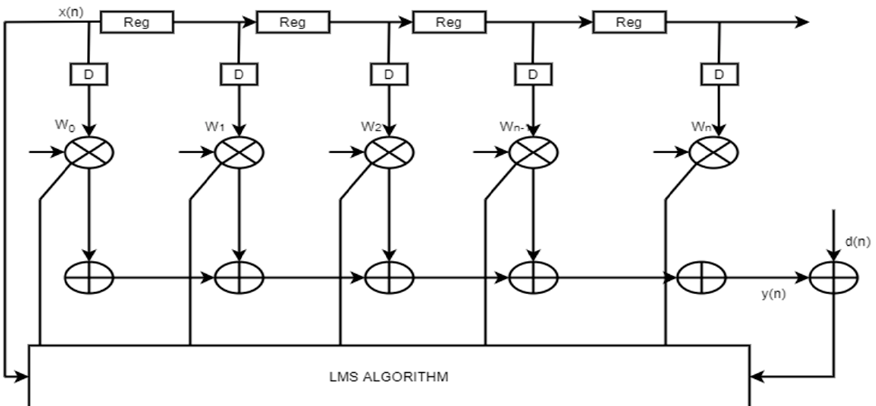
Figure 7. The conventional adaptive architecture.